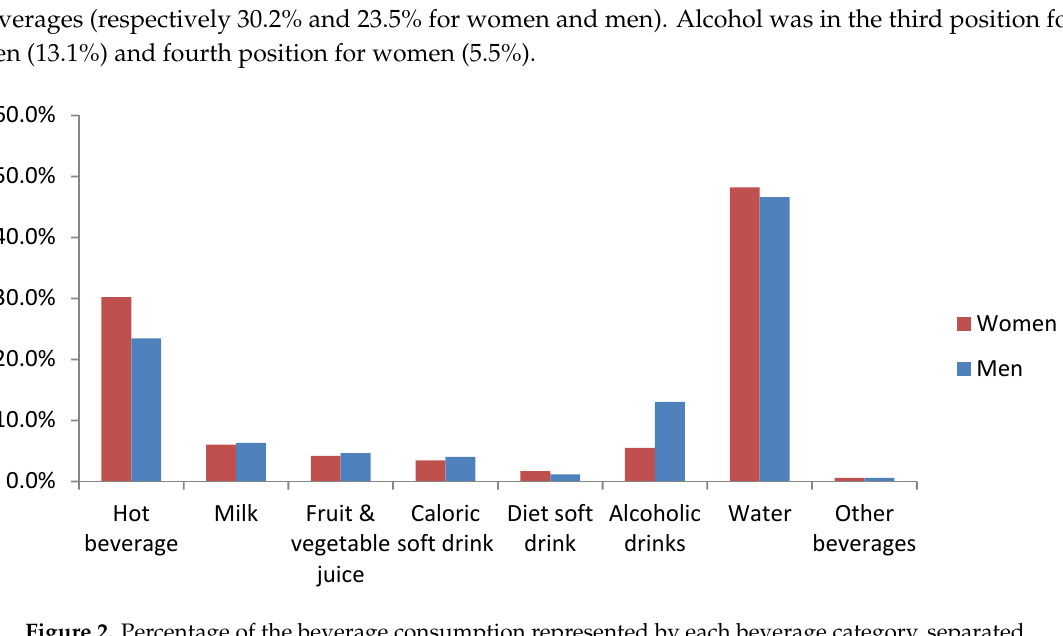
Figure 2. Percentage of the beverage consumption represented by each beverage category, separated by gender.